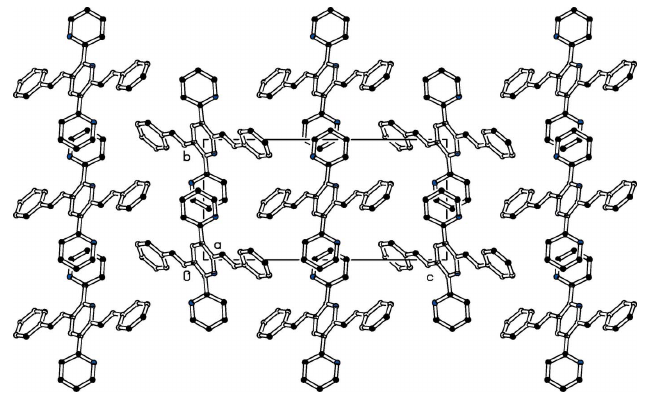
Figure 2 Partial packing diagram of the title compound. View along the a